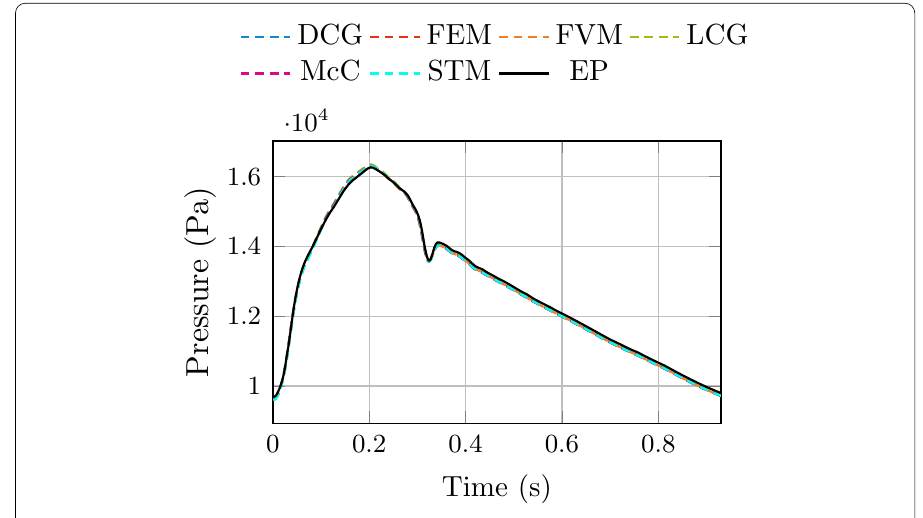
Fig. 6 Validation of the proposed energy-preserving formulation through the comparison of the results of our approach and those reported in [18]. DCG discontinuous Galerkin, FEM Galerkin least-squares finite